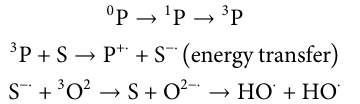
Frontiers in Bioengineering and Biotechnology |